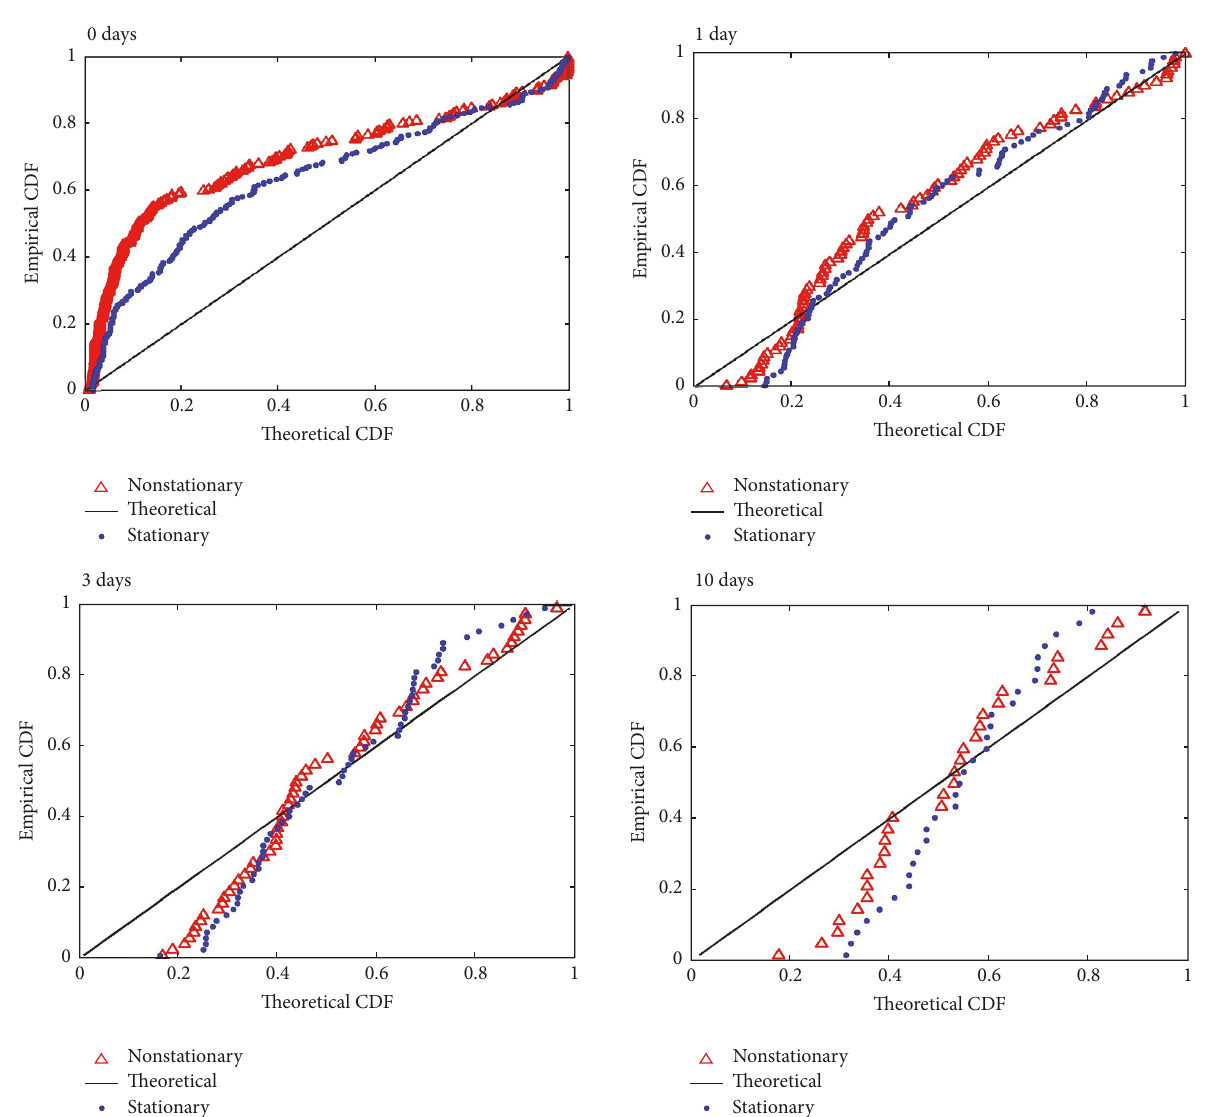
Figure 8: Comparison of several time spans in the fitting to stationary and nonstationary Poisson